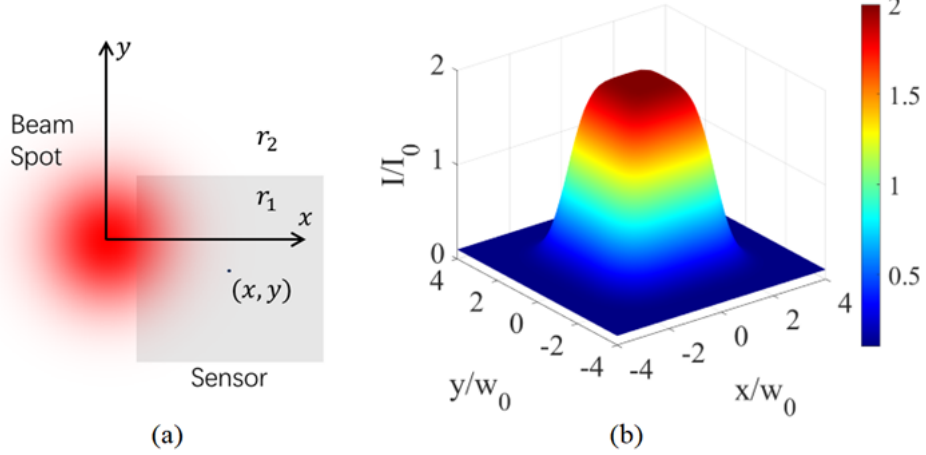
Figure 5. Intensity of reflected wave versus misalignment between a square sensor and the beam spot. ( a ) The beam spot of the fiber output and a sensor that has a different reflectivity than its surrounding substrate. ( b ) Intensity of the reflected wave as a function of the misalignment between the beam center and the center of the sensor, measured in units of the average intensity when the beam is entirely reflected by the sensor and the substrate. The reflectivity r 1 = 4.5 r 2 , the size of the square sensor is 4 w 0 × 4 w 0 , w 0 being the mode field radius of the